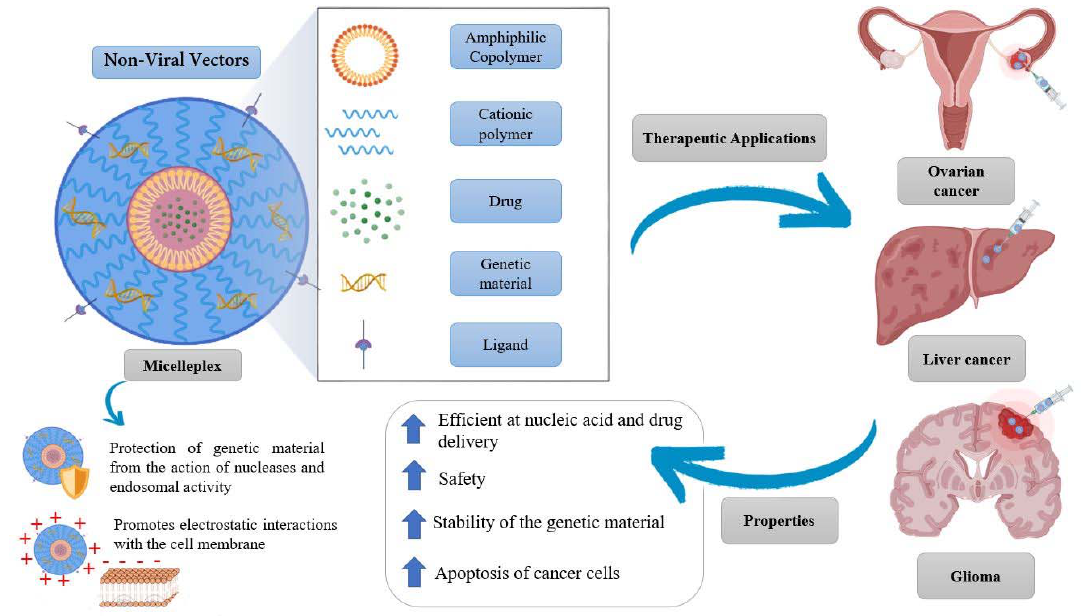
Figure 10. Basic structure and summary of the properties of micelleplexes as well as their therapeutic application in ovarian cancer, liver cancer, and glioma.